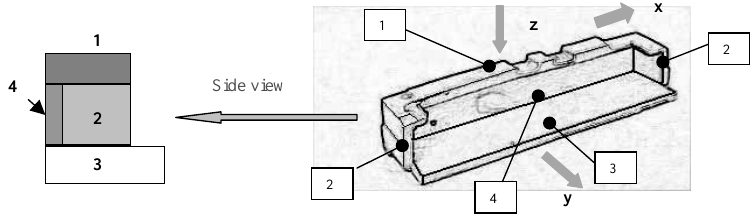
Fig. 10. Block 1, 2 and 3 in series and parallel with 4.